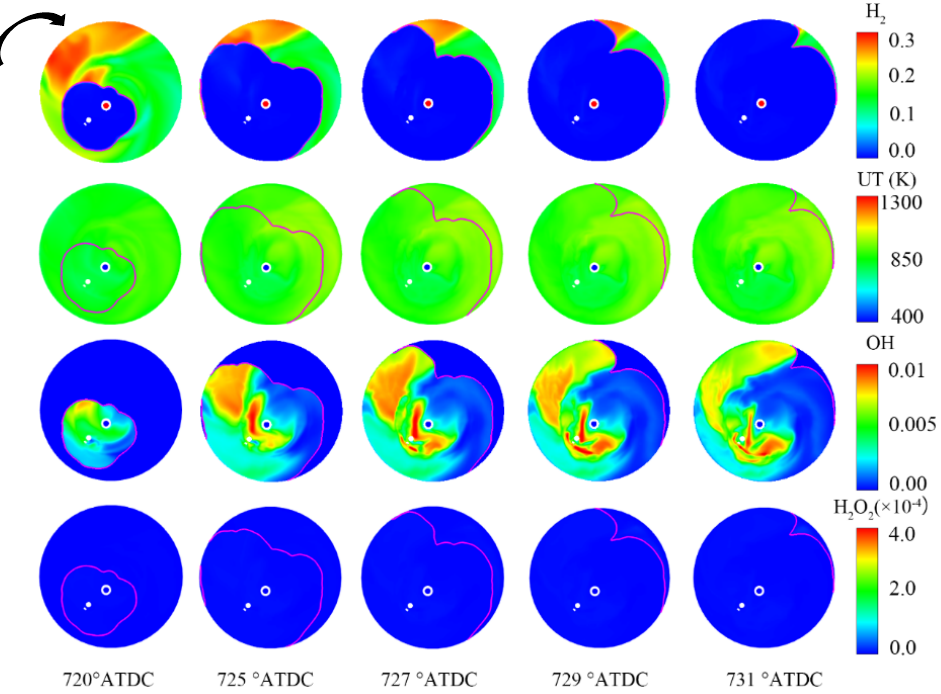
Figure 11. Flame propagation process and the change of important species in normal combustion [48].